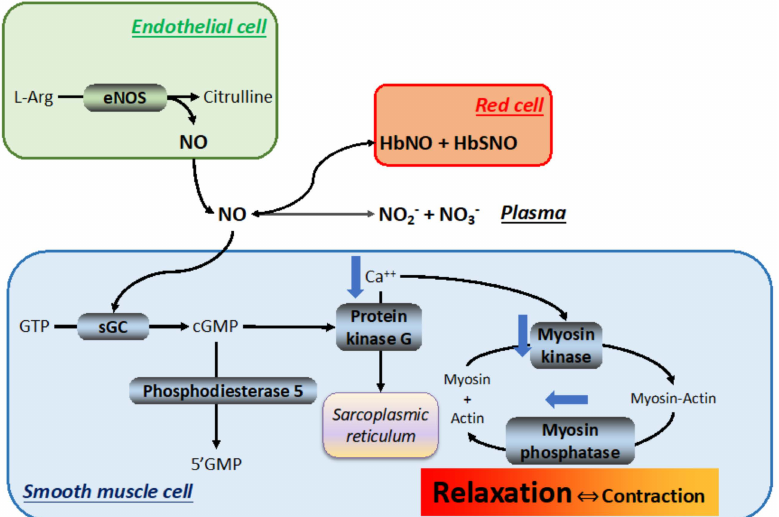
Figure 6. Simplified scheme of the mechanisms that modulate the NO–cGMP pathway in the smooth muscle cell. Four compartments are examined: the endothelial cells (green) that generate NO, the RBCs (red) that store NO as nitrosylated Hb (HbNO) or nitrosothiolated Hb (HbSNO), the plasma that stores NO as inorganic nitrites and nitrates (NO 2 − + NO 3 − ), and the smooth muscle cells (light blue). Here, NO favors the decrease in [Ca ++ ] that is sequestered in the sarcoplasmic reticulum, diminishing the activity of myosin kinase and favoring muscle